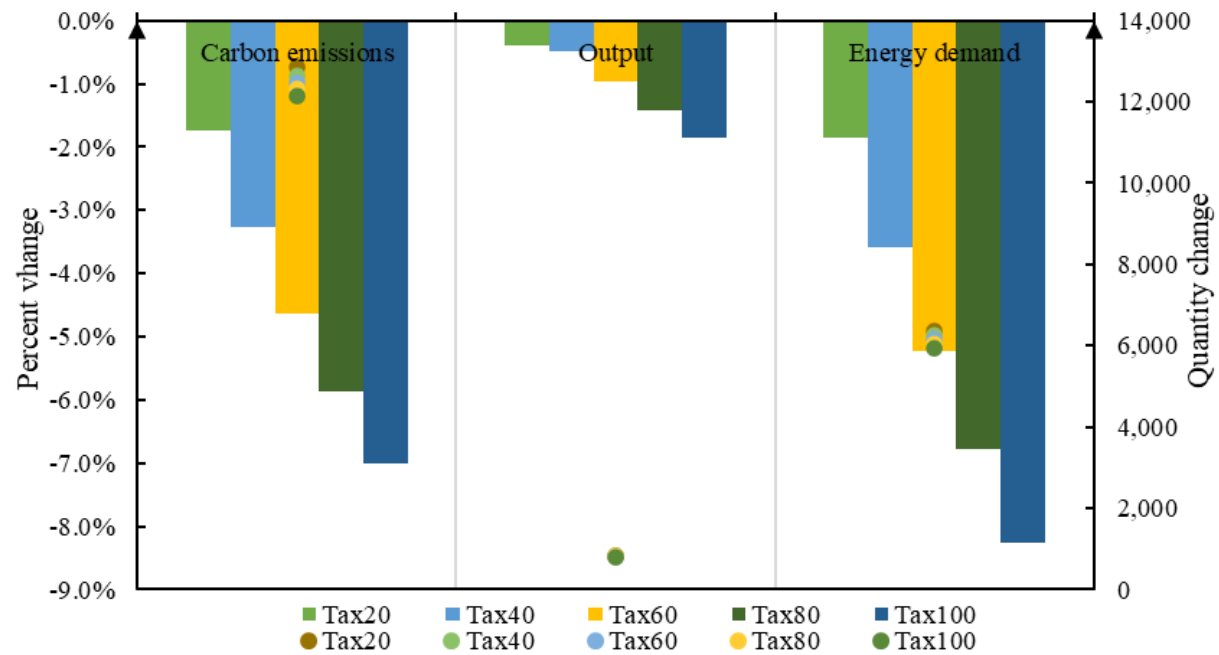
Figure 3. Impact of carbon tax on the construction industry.